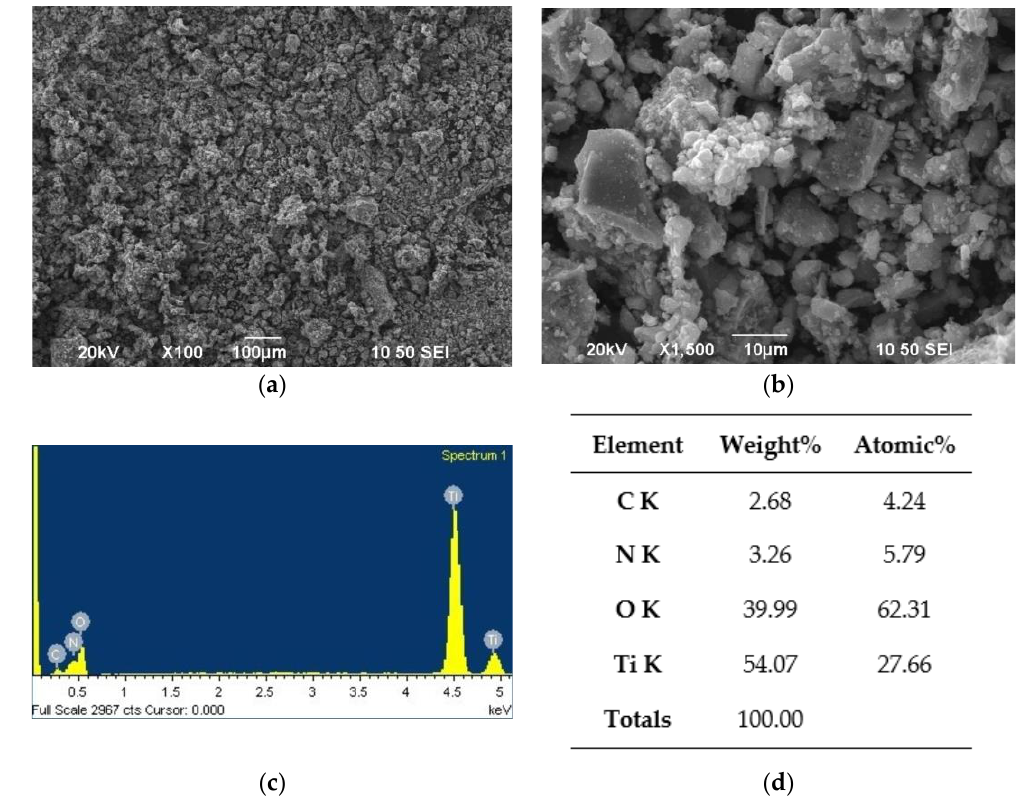
Figure 5. SEM/EDS analysis for the N-TiO 2 NPs: ( a ) ×100 magnification image of the powder, ( b ) ×1500 magnification image of the powder, ( c ) EDS spectrum of the powder, and ( d ) EDS analysis results of the powder.